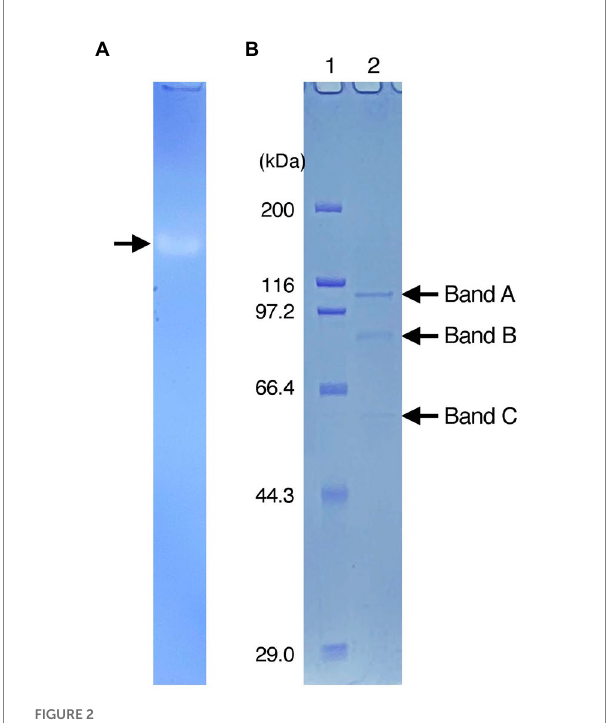
FIGURE 2 (A) Activity staining of Idr protein. The crude extracts were run on sodium dodecyl sulfate (SDS)-polyacrylamide gel electrophoresis at 4 ° C under non-denatured conditions (without SDS and reducing agents). After the electrophoresis, the gel was stained anaerobically with methyl viologen and iodate as the electron donor and acceptor, respectively. A clear band represents the active band. (B) Separation of the excised active band under completely denatured conditions (100 ° C, 5 min with SDS and 2-mercaptoethanol). The gel was stained with Coomassie brilliant blue R-250. Lane 1 represents the standard marker proteins. Three bands with molecular weights of approximately 100 kDa (band A), 80 kDa (band B), and 50 kDa (band C) were